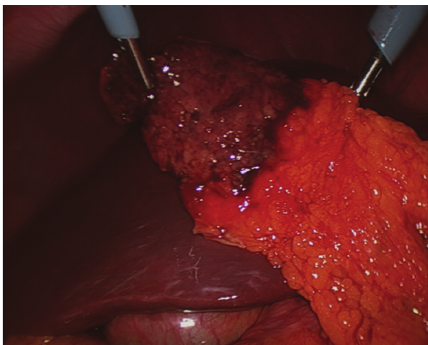
Figure 1: Intraoperative image of the infarcted omental segment following mobilization from the anterior abdominal wall.